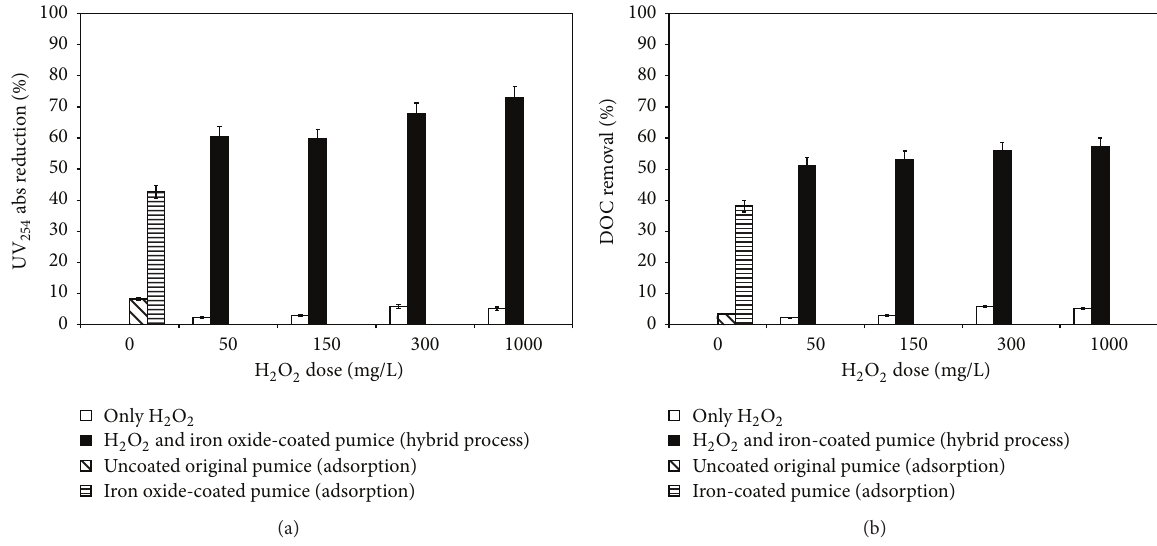
Figure 2: NOM removals in MB water by the original or iron oxide-coated pumice particles (adsorption only), hydrogen peroxide alone, and the hybrid process (iron oxide-coated pumice and peroxide). UV reductions (a) and DOC removal (b). < 63 𝜇 m Isp pumice, pumice dose: 3000 mg/L, reaction period: 24h, and initial DOC: 4.1mg/L. Error bars indicate the 95% confidence